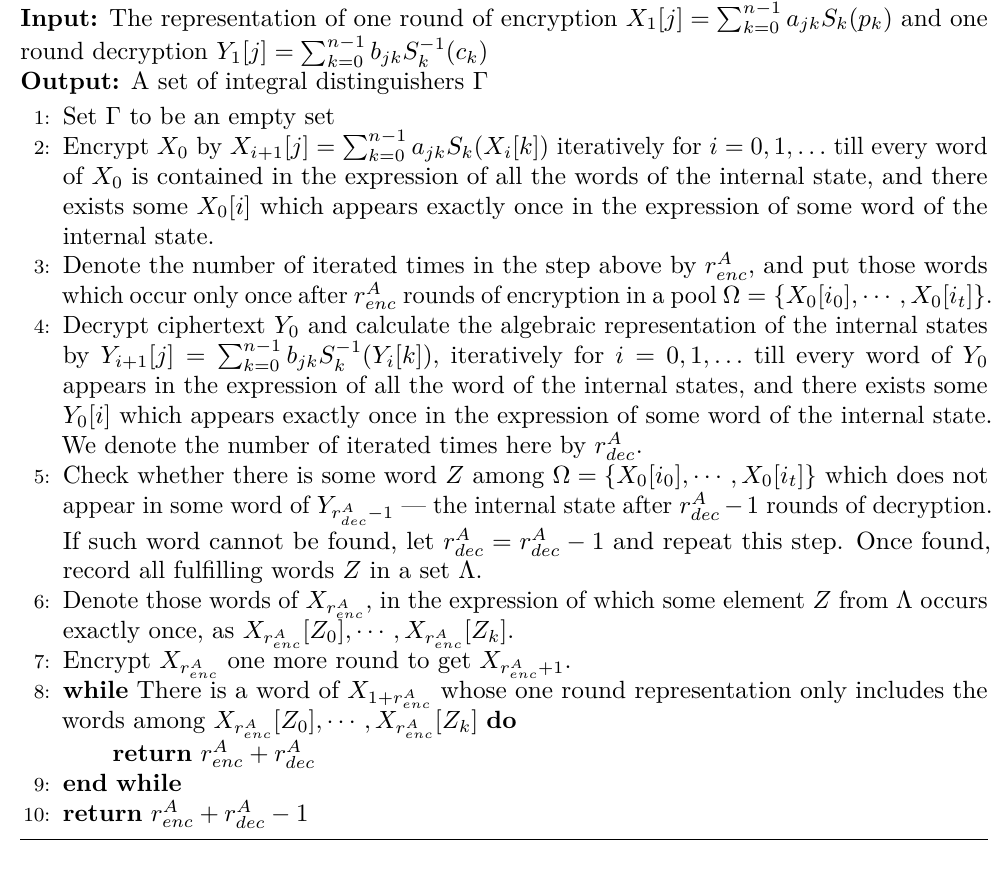
Algorithm 1 Finding an integral distinguisher of maximum